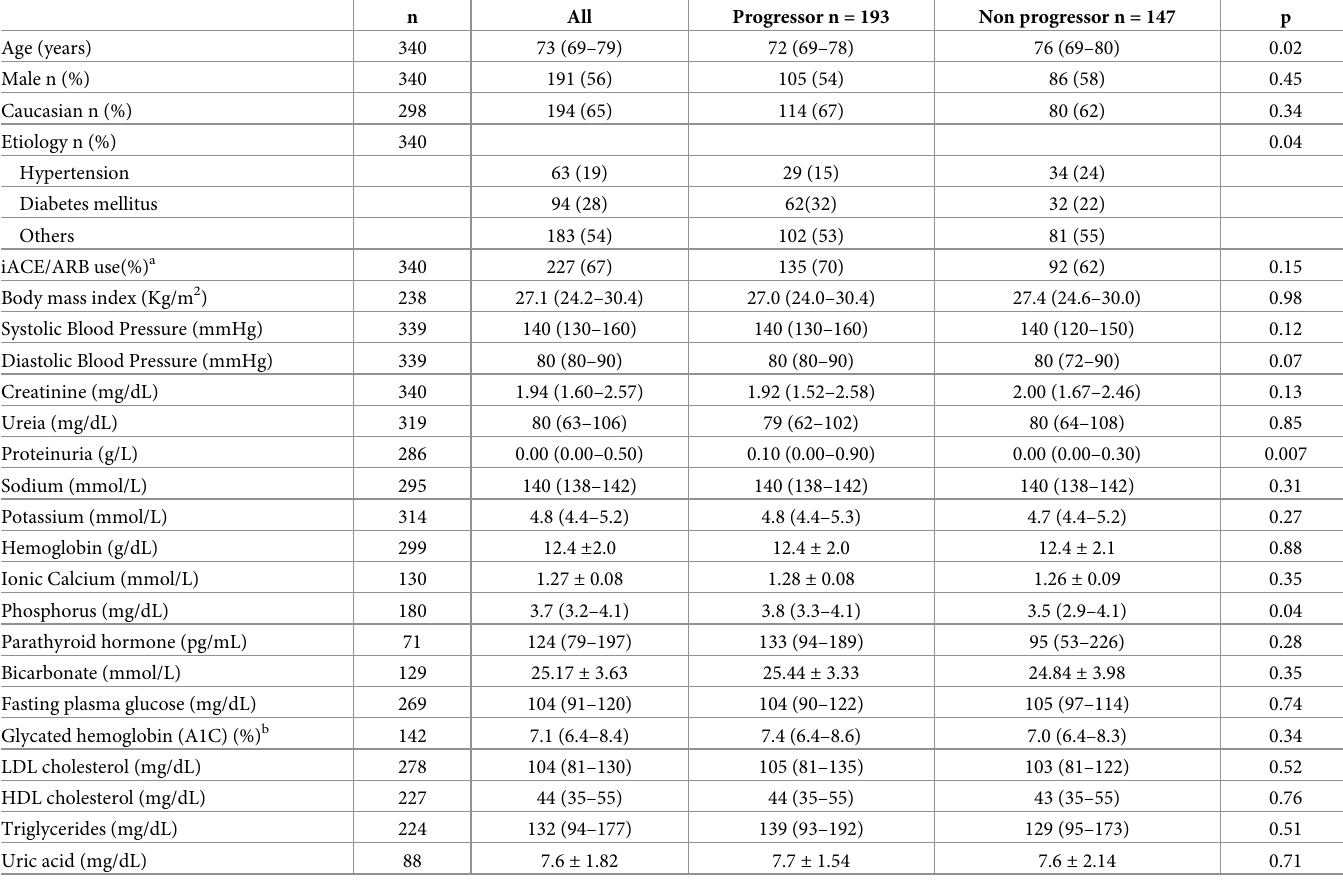
Table 1. Characteristics of all patients and comparison of demographic, clinical and laboratory parameters inter